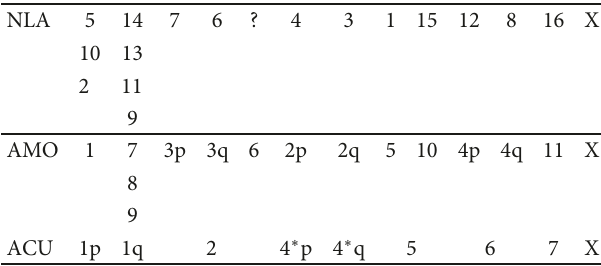
∗ The metacentric chromosome was used for comparison; p= short arm; q =long